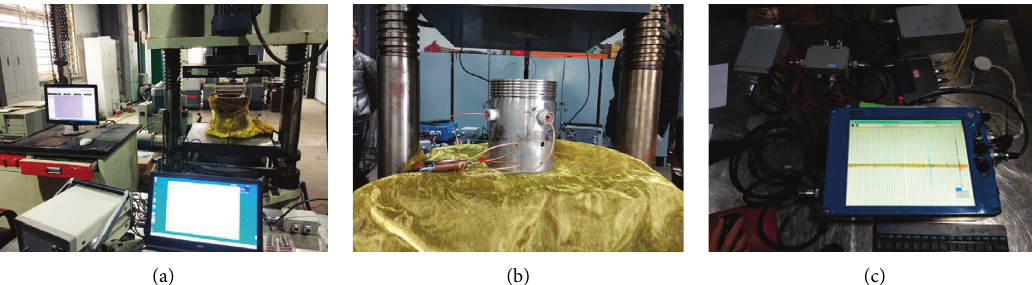
Figure 2: The uniaxial loading system [13]: (a) the loading machine and measuring system; (b) signal shielding device; (c) data collection